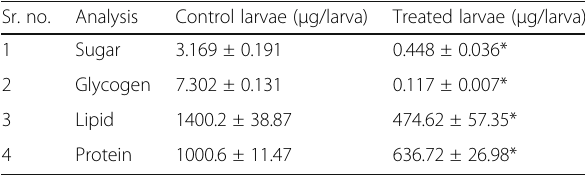
Table 3 Effect of bay EO on nutritional reserves of M. domestica larvae Sr. no. Analysis